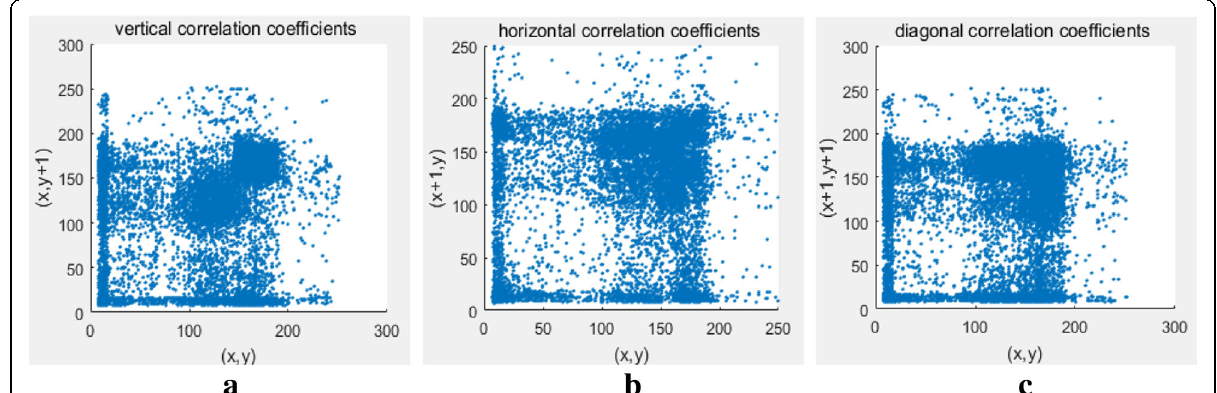
Fig. 10 a Vertical correlations of scrambled images. b Horizontal correlations of scrambled images. c Diagonal correlations of scrambled